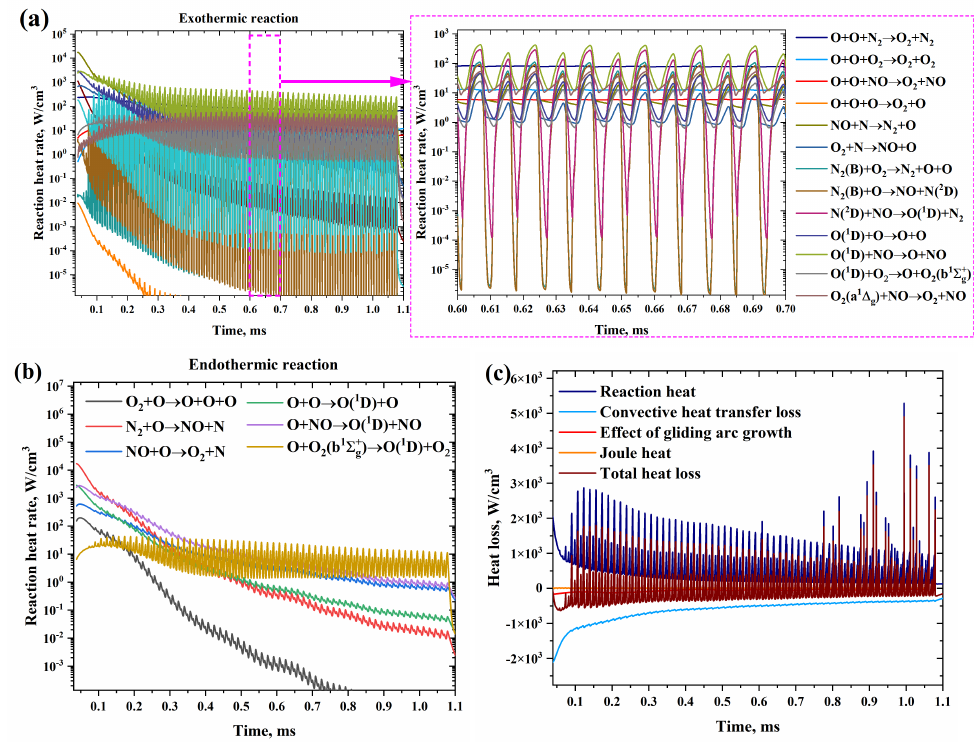
Figure 14. Source rate analysis of ( a , b ) reaction heat and ( c ) the gas temperature in the non– equilibrium